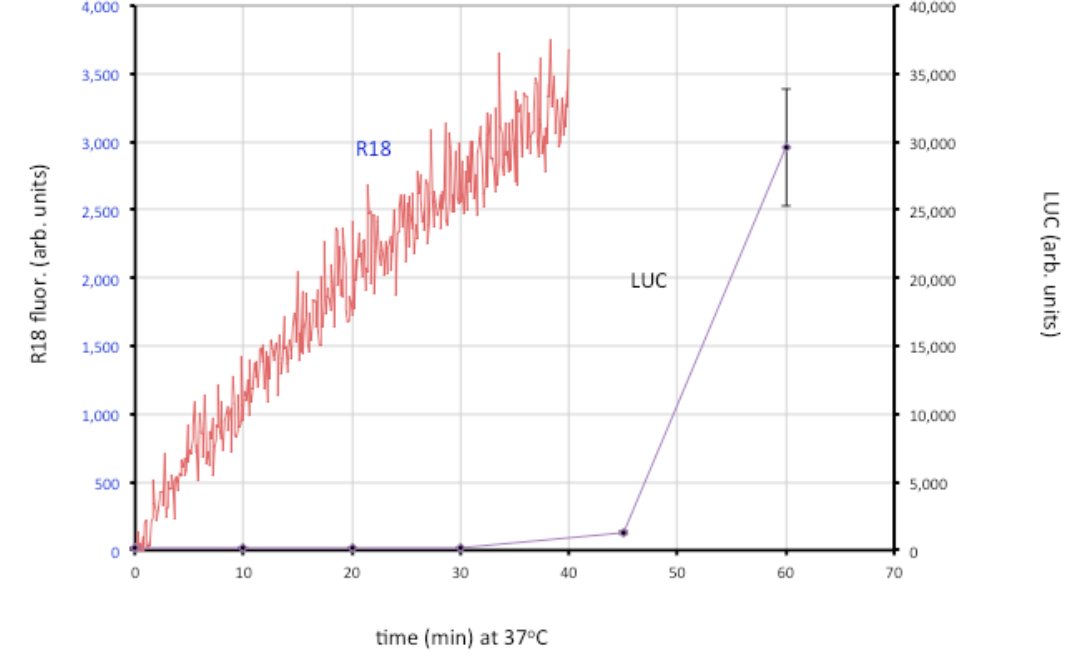
Figure 4. Membrane fusion and core entry. R18-loaded MVs that express firefly luciferase were incubated with HeLa cells at 4 °C to permit binding. Washed cells were then placed in a cuvette containing pre-warmed media at 37 °C and fluorescence was monitored over time (red line; left y-axis). In parallel, unlabeled MVs were bound to cells in the cold and then shifted to 37 °C. Cell lysates were prepared at indicated times and assayed for luciferase (LUC) activity (purple line; right y-axis). Modified from ref